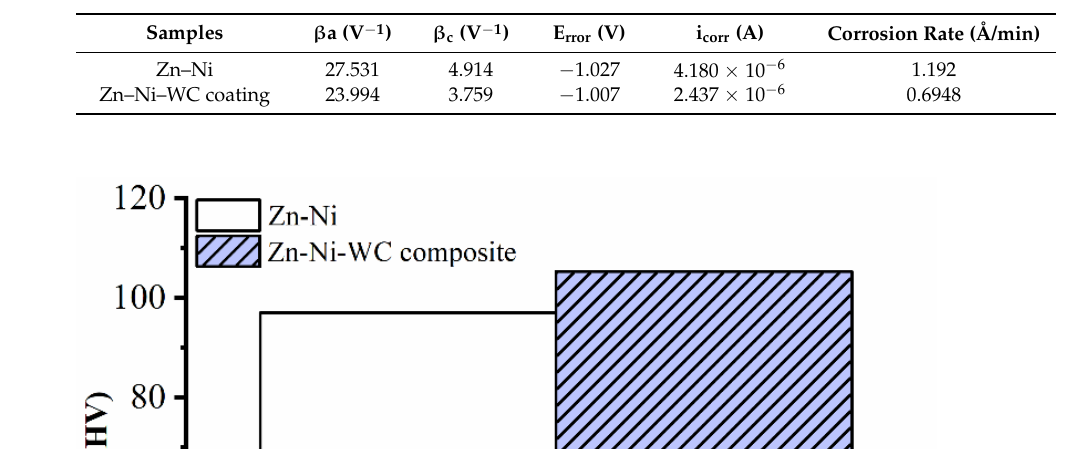
Table 2. Electrochemical parameters of the coatings derived from potentiodynamic plots.